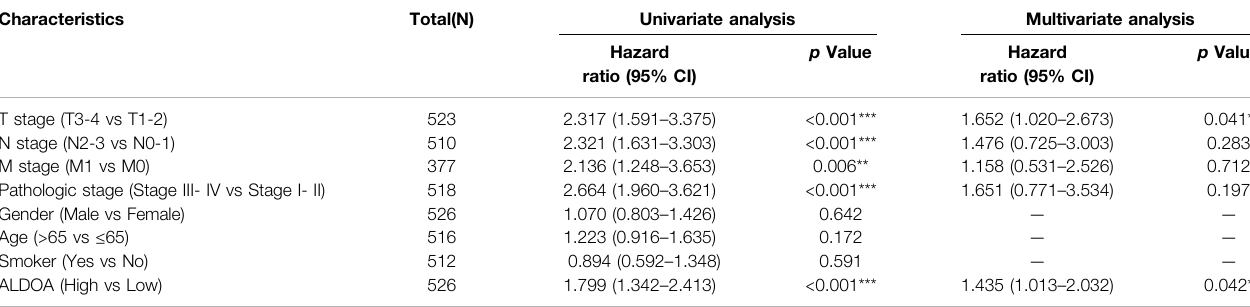
TABLE 2 | Univariate and multivariate analyses of prognostic variables for overall survival.